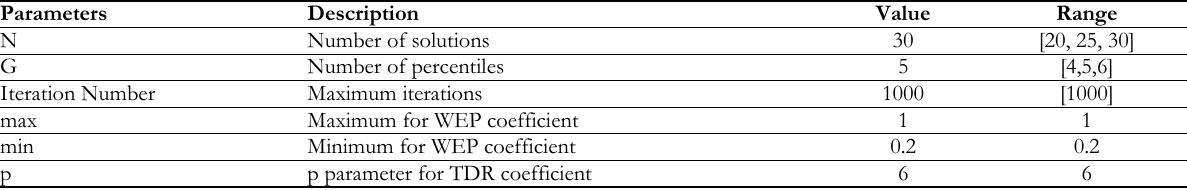
Table 1. Setting of parameters for binary multi-verse search algorithm